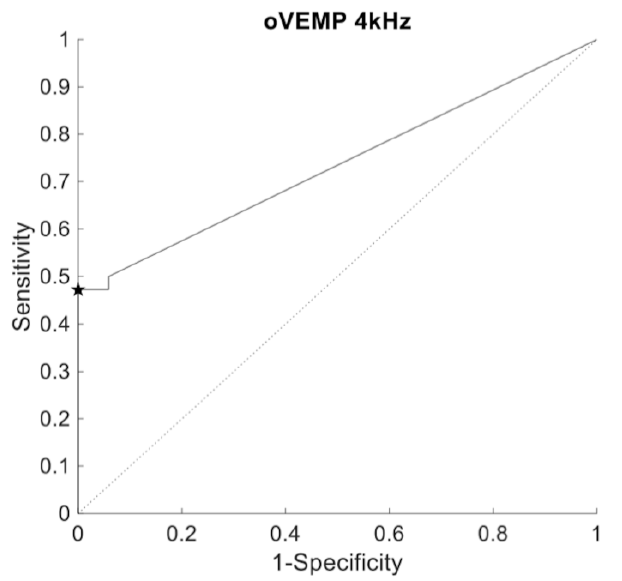
Figure 7. ROC curve representing the diagnostic value of oVEMP (4 kHz) amplitude. The star symbol represents sensitivity and specificity for the given cutoff value.